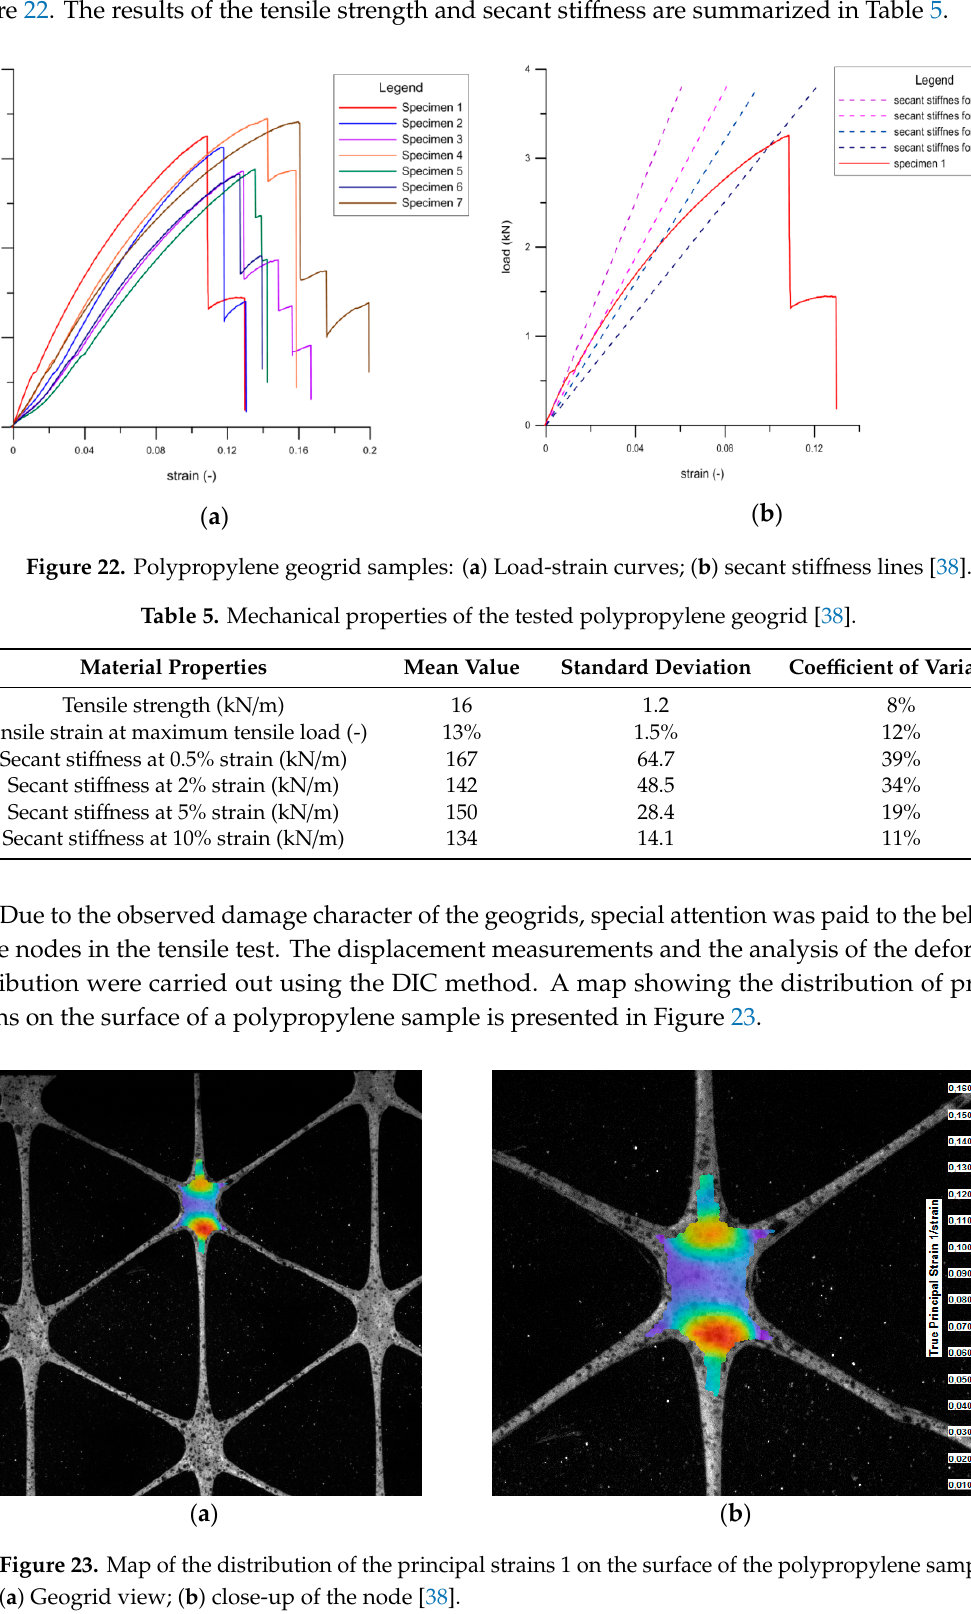
Figure 22. The results of the tensile strength and secant sti ff ness are summarized in Table 5.